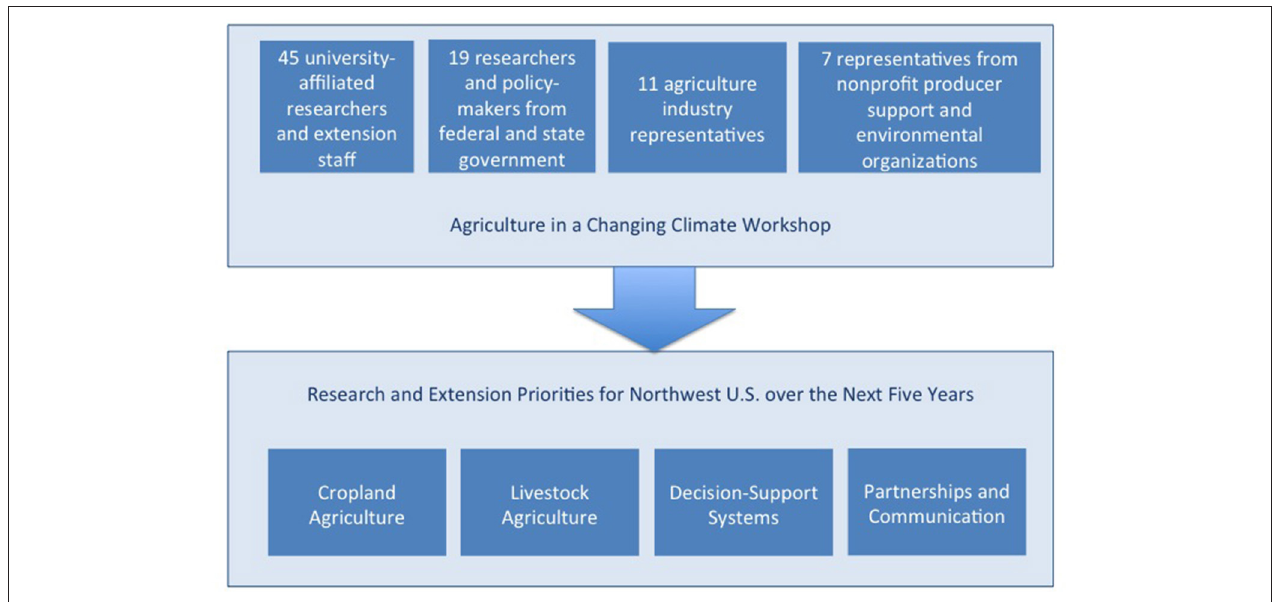
FIGURE 1 | During the “Agriculture in a Changing Climate Workshop,” 82 participants from across the research-practice continuum worked collaboratively to identify priorities relating to climate change and Northwest U.S. agriculture in four focus areas: cropping systems, livestock systems, decision support systems, and partnerships and